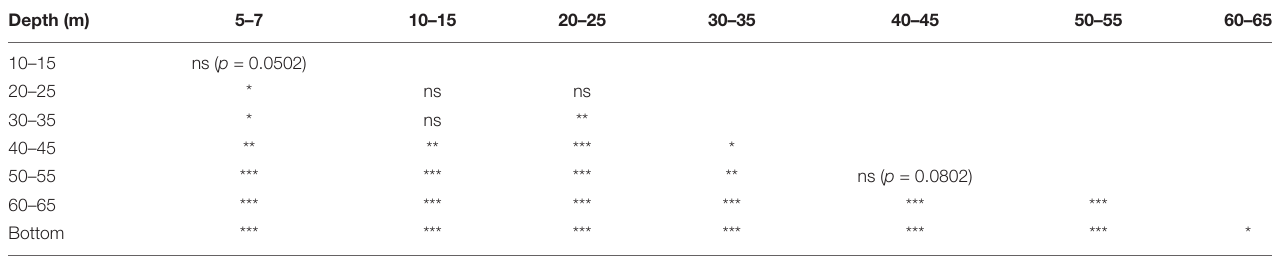
TABLE 5 | PERMANOVA pairwise comparisons of depth